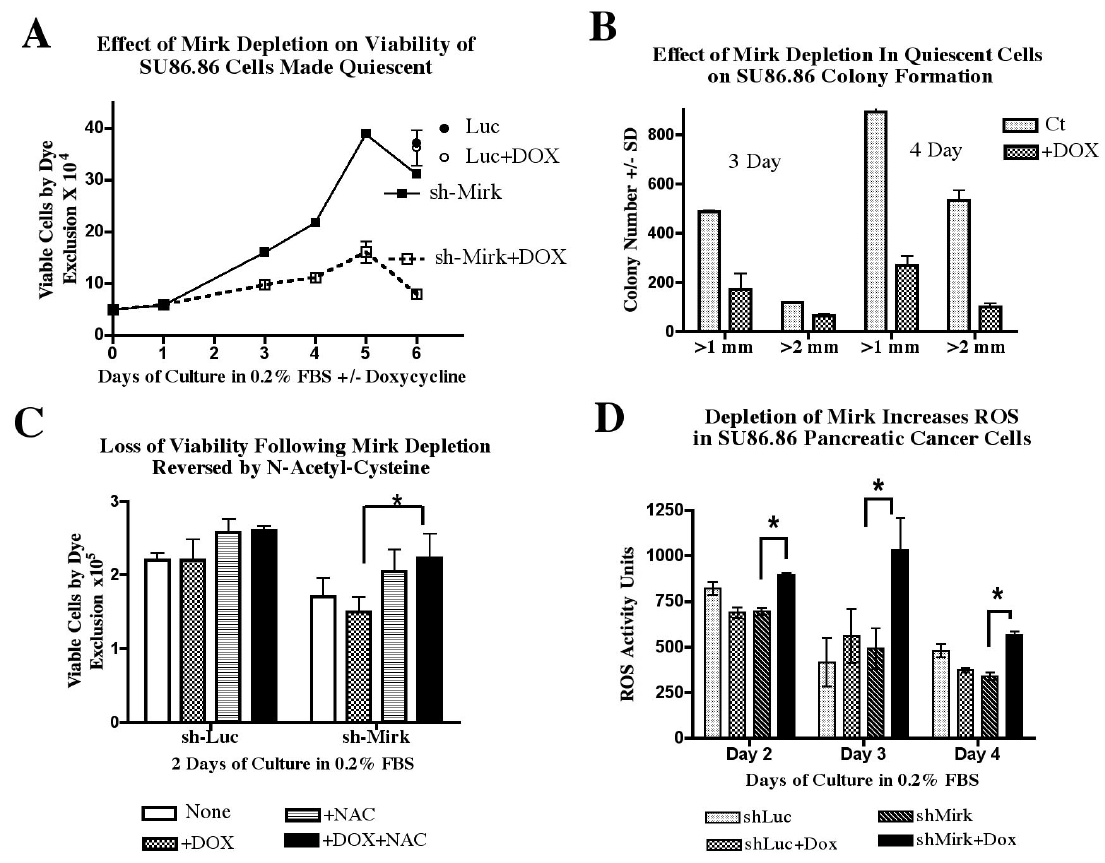
Figure 6. Mirk depletion leads to loss of viability and an increase in ROS in quiescent SU86.86 cells. ( A ). Viability by trypan blue exclusion assay: SU86.86/sh-Mirk and control SU86.86/luc (luciferase gene) cells were cultured for up to six days in medium containing 0.2% FBS to induce a quiescent state. Viable cells were counted using a phase microscope after staining with trypan blue dye. Mean ± SEM shown if SEM > 5%. ( B ). Viability by colony formation assay: Colonies arising from SU86.86/sh-Mirk cells made quiescent 3 or 4 days, then grown in DMEM containing 10% FBS without doxycycline, were counted with an automatic colony counter, selecting for colonies of diameters of at least 1 mm or 2 mm. ( C ). SU86.86/sh-Mirk and control SU86.86/luc cells were made quiescent for two days and then assayed for viable cells, as in panel A, with the addition of the antioxidant N-acetyl-cysteine (NAC) at 1 mM as noted. ( D ). SU86.86/sh-Mirk cells and control SU86.86/Luc cells were made quiescent and their ROS species detected with CM-H DCFA using a fluorometer. (Reprinted with permission from 2